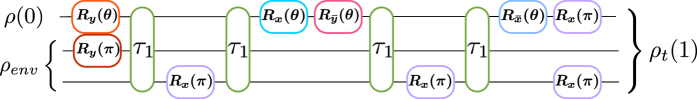
Quantum circuit representing the NMR pulse sequence for implementing the first collision.The boxes with the symbols Rα(θ) indicate that a rotation of the angle θ on that particular spin was performed around the α direction and . The boxes with the symbol τ1 represent a free evolution of the system and environment for a period of time τ1. After the first collision, the resulting quantum state of system and environment is represented by ρt(1). τ1 is the time needed such that a rotation of π/2 occurs in the system and here it will be given by  s.